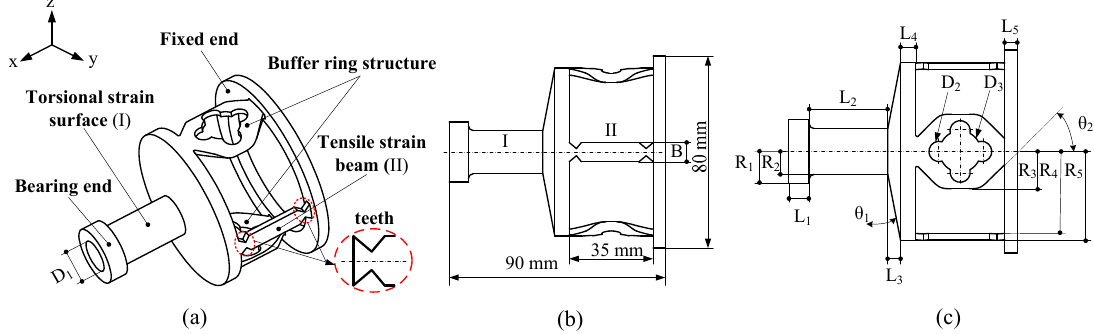
Figure 2. The structure of the sensor: ( a ) three-dimensional model, ( b ) main structure dimension, and ( c ) specific structure dimensions.